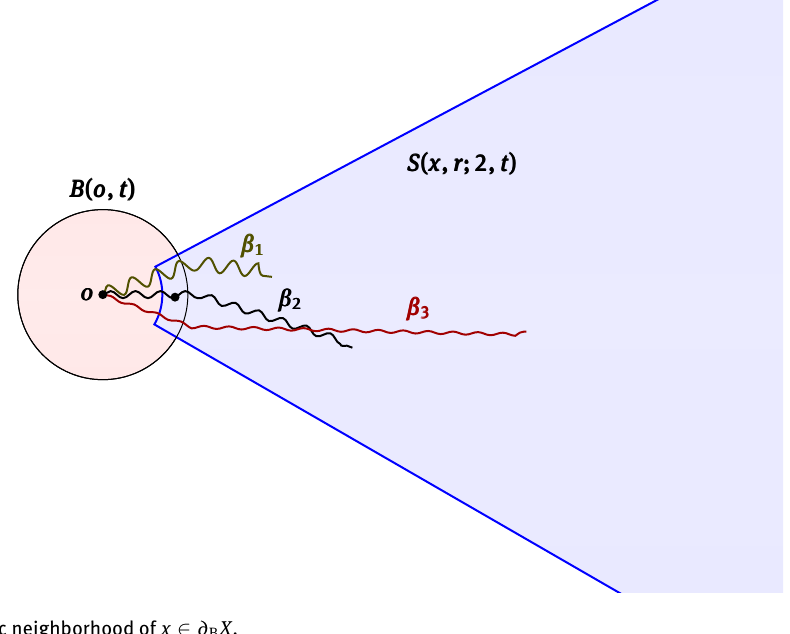
Fig. 1. A basic neighborhood of x ∈ ∂ B X